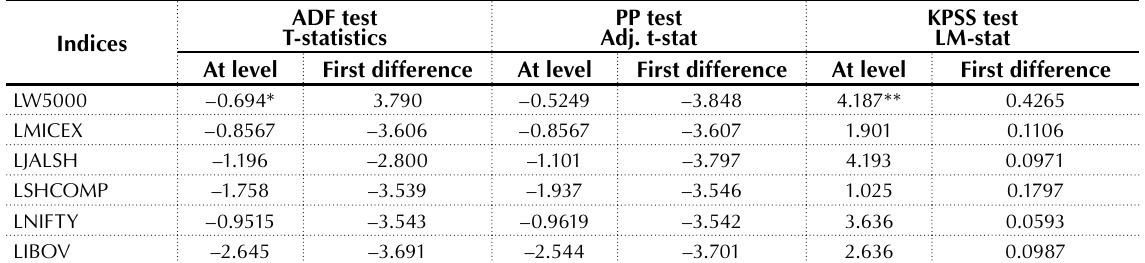
Table 3. Unit root tests